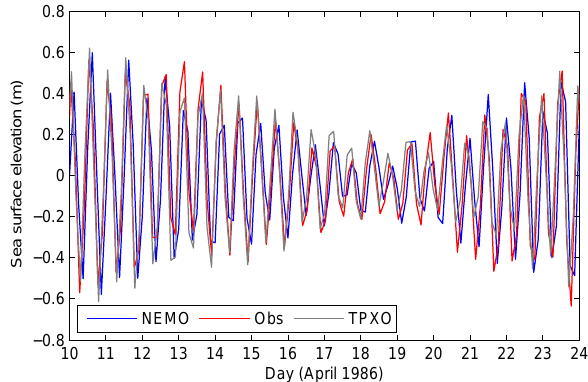
Fig. 2. Comparison of tidal sea level elevation at Ny-Ålesund (ap- proximately 78.95 ◦ N, 11.95 ◦ E). Data sets shown: NEMO model (blue), UHSLC tide gauge 823A (red) and TPXO7.2 tidal model (grey). Note that the vertical axes of the original data sets have been shifted to a uniform reference height.